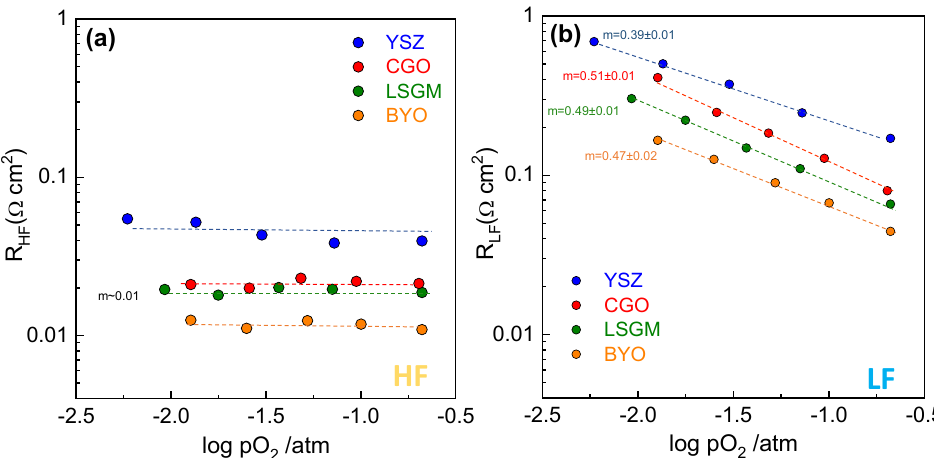
Figure 7. Polarization resistances of the ( a ) HF and ( b ) LF electrode contributions of LSCF with dif ‐ ferent electrolytes as a function of the oxygen partial pressure at 700 °C.